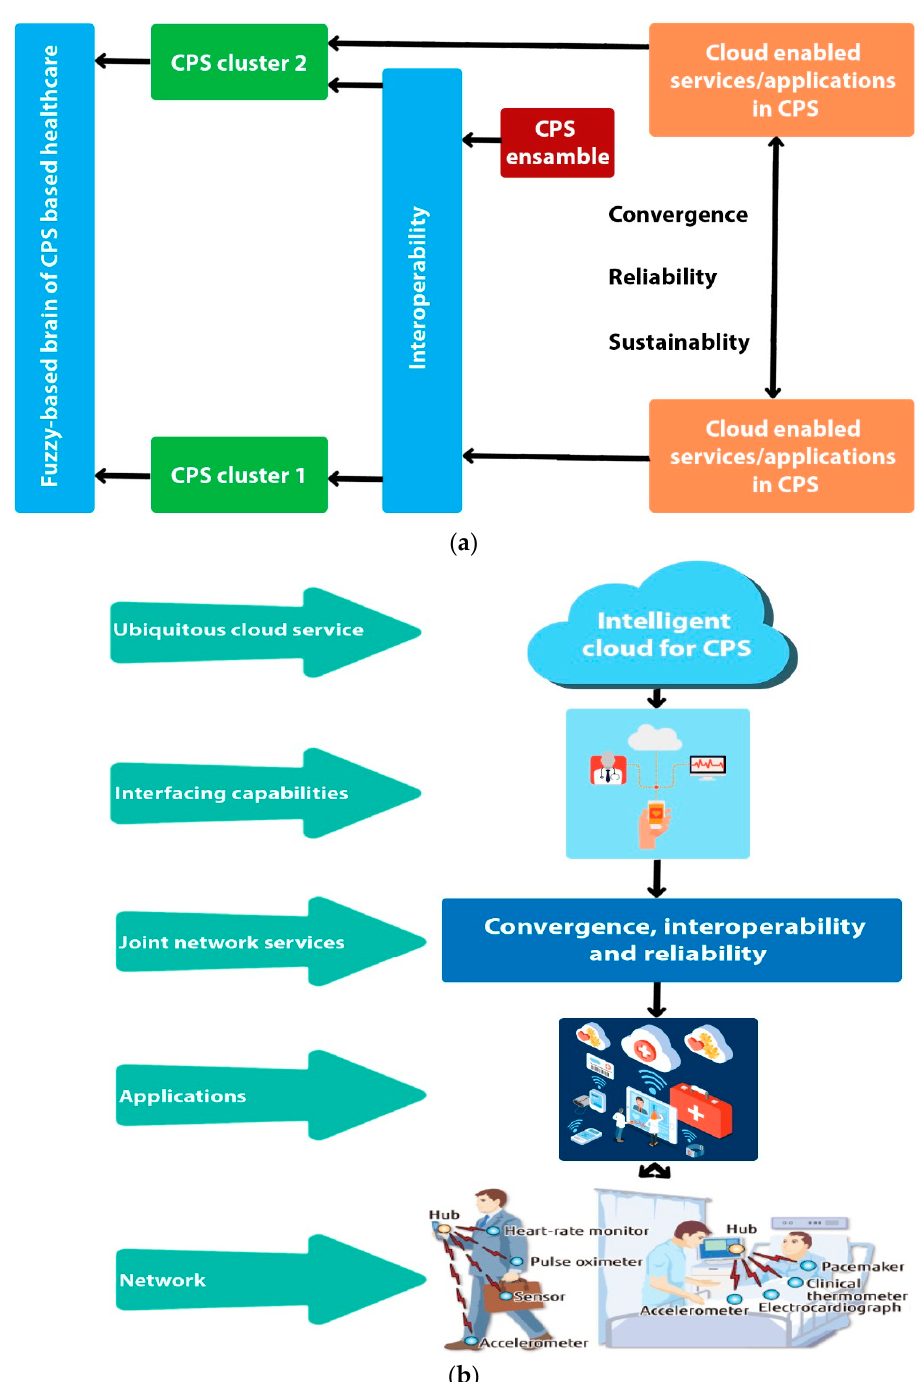
Figure 4. Proposed joint convergent, interoperable, and reliable healthcare: ( a ) block diagram, ( b ) 6G